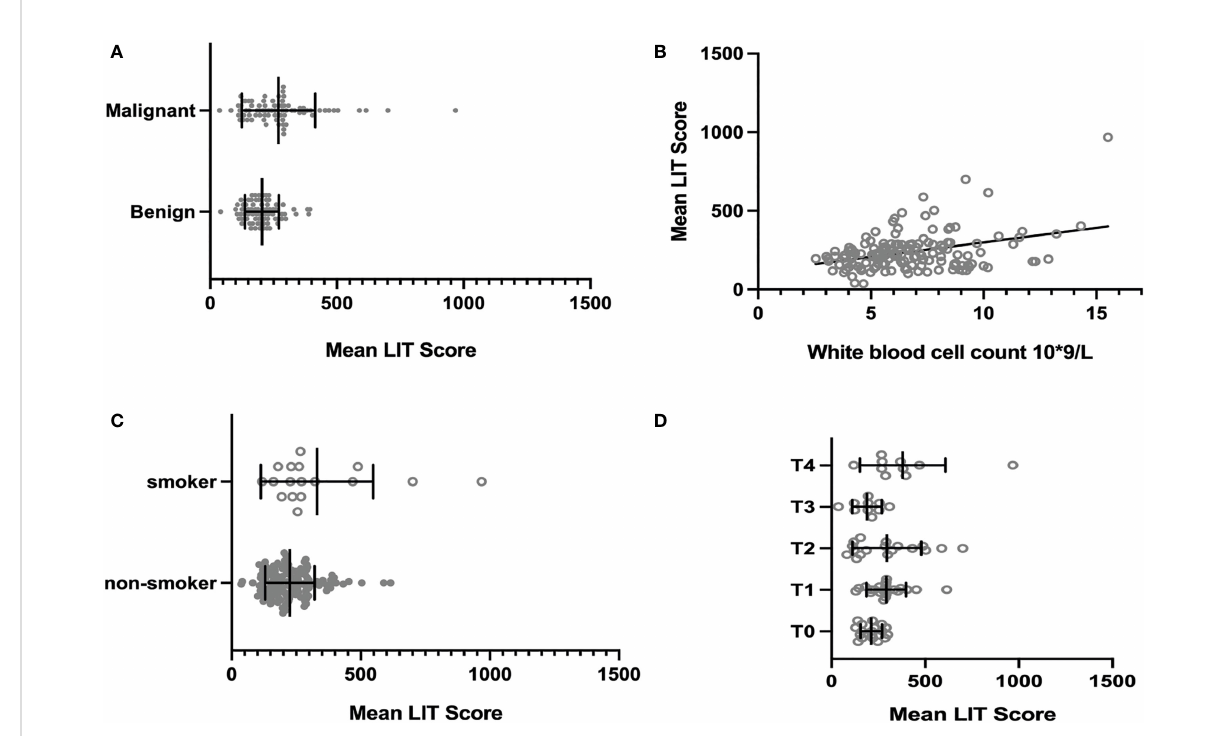
FIGURE 1 The association between all patients ’ clinical or tumor-related characteristics and their Leukocyte ImmunoTest (LIT) score. (A) The mean LIT score of cancer group and control group. The mean LIT score of cancer group was signi fi cantly higher than that of control group (p-value = 0.0004). (B) The correlation between mean LIT score and white blood cell count. The mean LIT score and white blood cell count were positively correlated in all patients (p-value < 0.05). (C) The mean LIT score of smokers and non-smokers. The mean LIT score of patients who